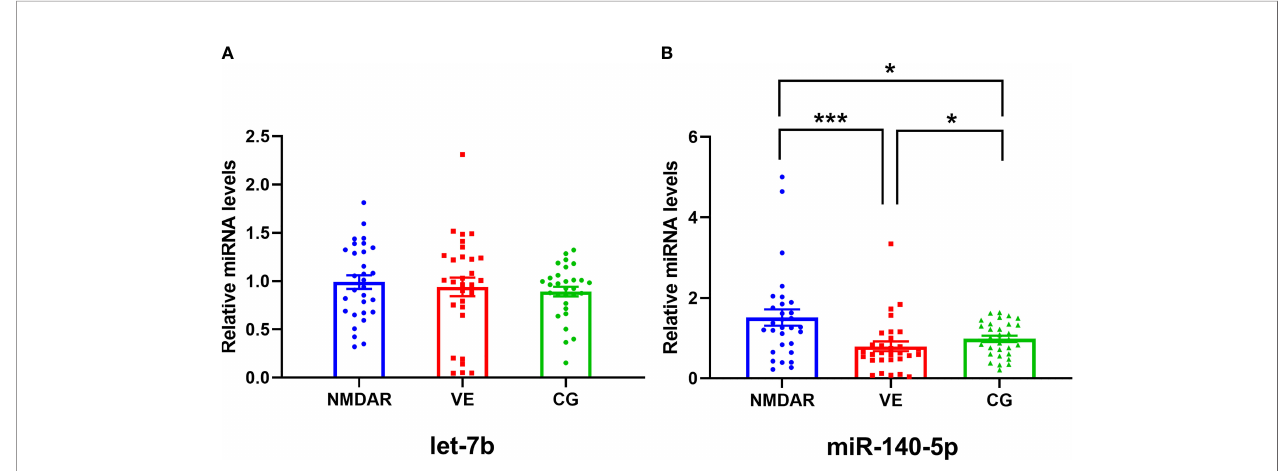
FIGURE 2 | The expression levels of let-7b and miR-140-5p in serum exosomes in three groups. (A) The expression level of let-7b among the NMDAR, VE, and CG groups. (B) The expression level of miR-140-5p among the NMDAR, VE, and CG groups. (*** p < 0.001; * p < 0.05; NMDAR, anti- N -methyl- D -aspartate receptor encephalitis; VE, viral encephalitis; CG, control group).